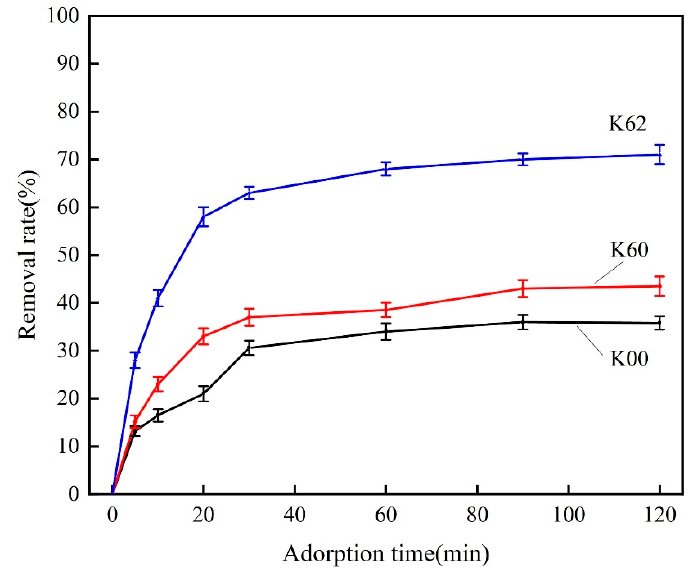
Figure 5. Adsorption of methyl orange solution on kaolin before and after modi fi